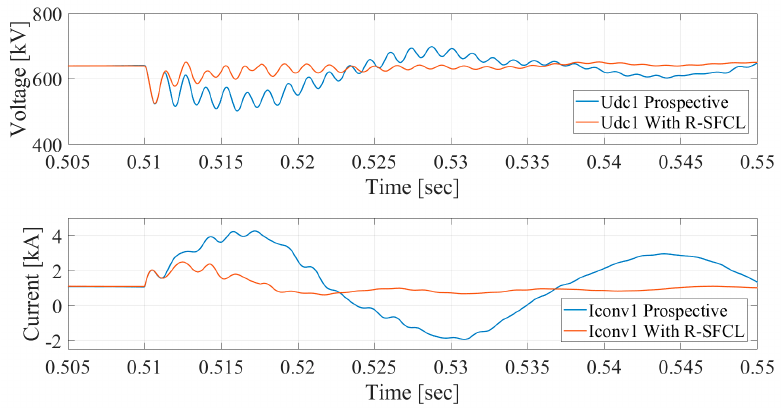
Figure 22. Converter 1 behavior with and without current limiter under pole-to-ground fault in Link 12 near Bus 1.